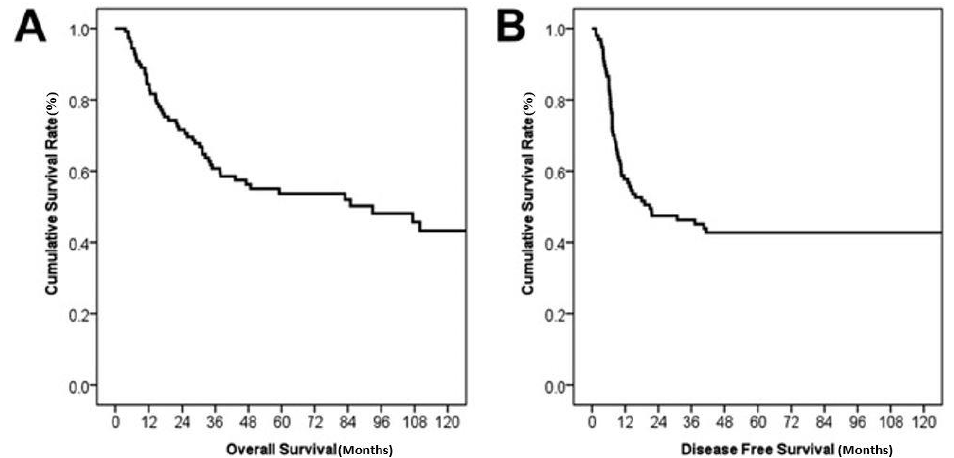
Figure 2. Kaplan – Meier survival curves of overall survival and disease free survival ( n = 109). ( A ) The median overall survival was 92.9 months, and the estimated 1-, 2-, and 5-year survival rates were 84.4%, 71.6%, and 53.7%, respectively. ( B ) The median disease free survival was 20.9 months, and the estimated 1-, 2-, and 5-year disease free survival rates were 57.7%, 47.4%, and 42.7%, respectively.